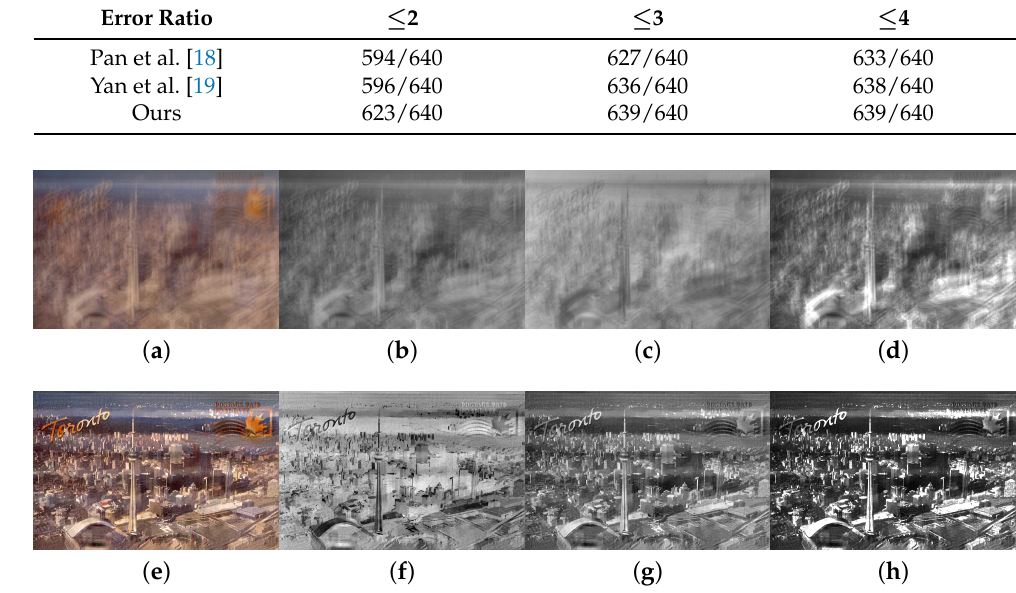
Figure 13. Visual comparison of different maps. ( a ) is blurry image. ( b – d ) are dark channel, bright channel and our D/B map of ( a ), respectively. ( e ) is recovered image. ( f , g ) are dark channel, bright channel and our D/B map of ( h ), respectively.